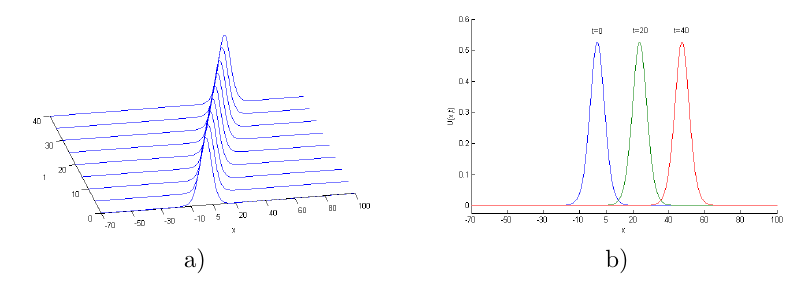
Figure 1. Results for a = b = c = 1, d = 0 . 5, v = 1 . 18 and h = ∆t = 0 . 1: a) single solitary wave profile, b) motion of single solitary wave at specified times.